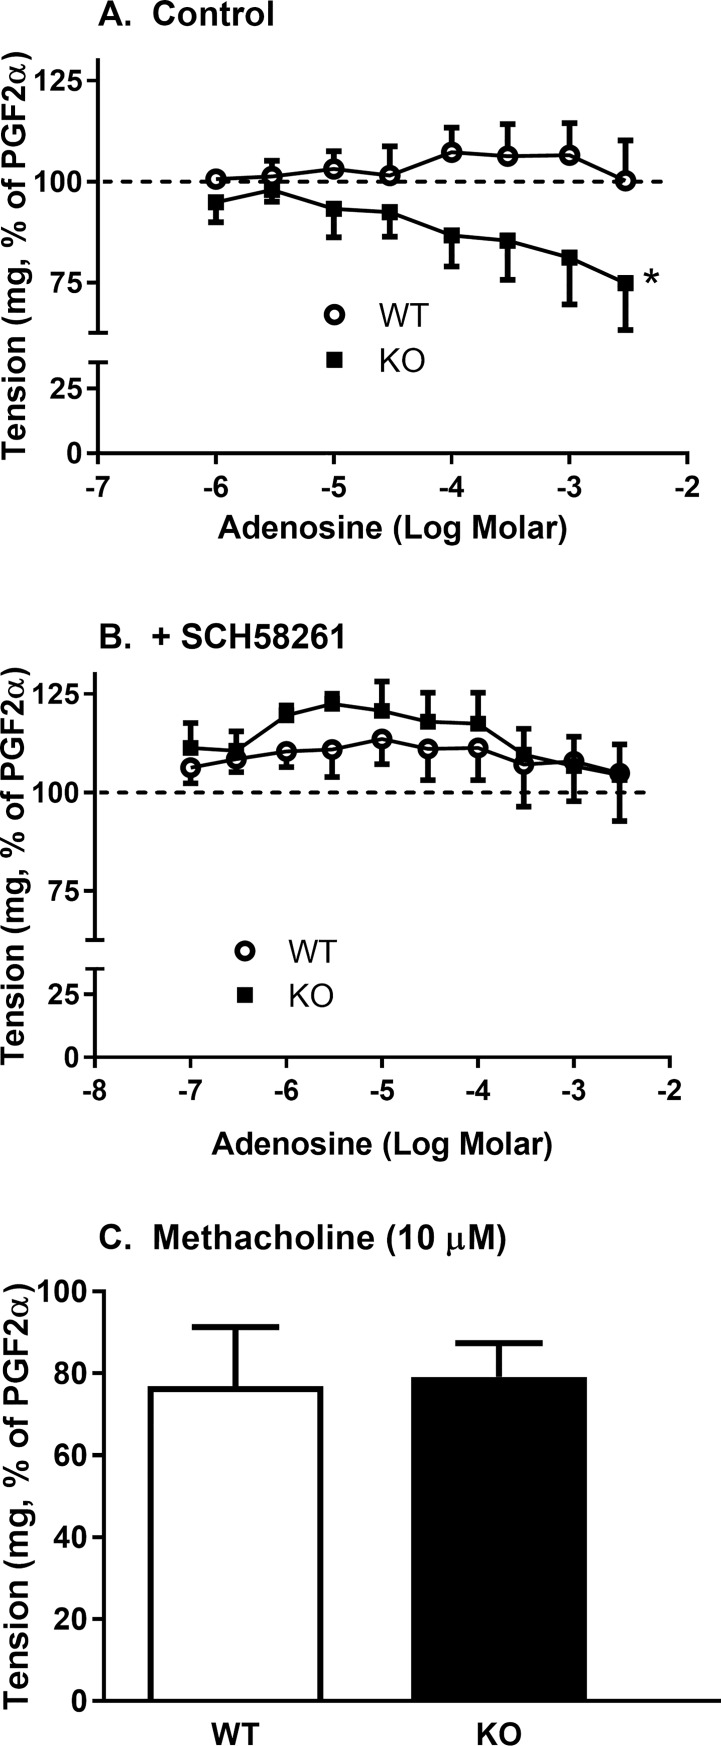
Adenosine induced vasodilation of thoracic aortas isolated from wild-type (WT) and Slc29a1-null (KO) mice.Tissues were incubated for 30 min at 37°C in KPSS buffer at resting tensions of 500 mg after which they were depolarized with 100 mM KCl to test for viability. Aortic rings were pre-constricted with PGF2α to 80% of maximum (dose range 1 μM– 10 μM) and then exposed to increasing concentrations of adenosine at two min intervals, in the absence (Control; Panel A) or presence (Panel B) of the adenosine A2 receptor blocker SCH58261 (100 nM), or 10 μM methacholine (Panel C). Relaxation responses were expressed as a percentage of the initial PGF2α contraction (shown by a dashed line in Panels A and B). Each point represents the mean ± SEM from 5 experiments. *Significant difference in response between aortic rings from wild-type and Slc29a1-null mice (Two-Way ANOVA for unpaired experimental parameters, *P<0.05).